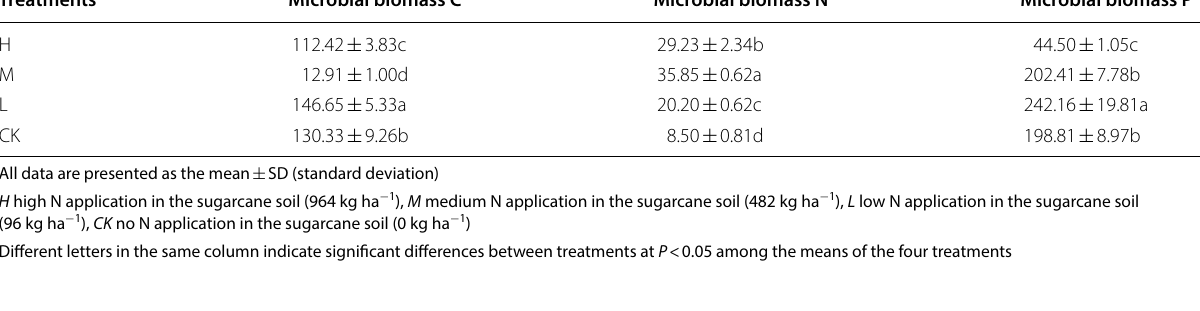
Table 3 Indexes of soil bacterial diversity and richness in sugarcane fields under four N application treatments